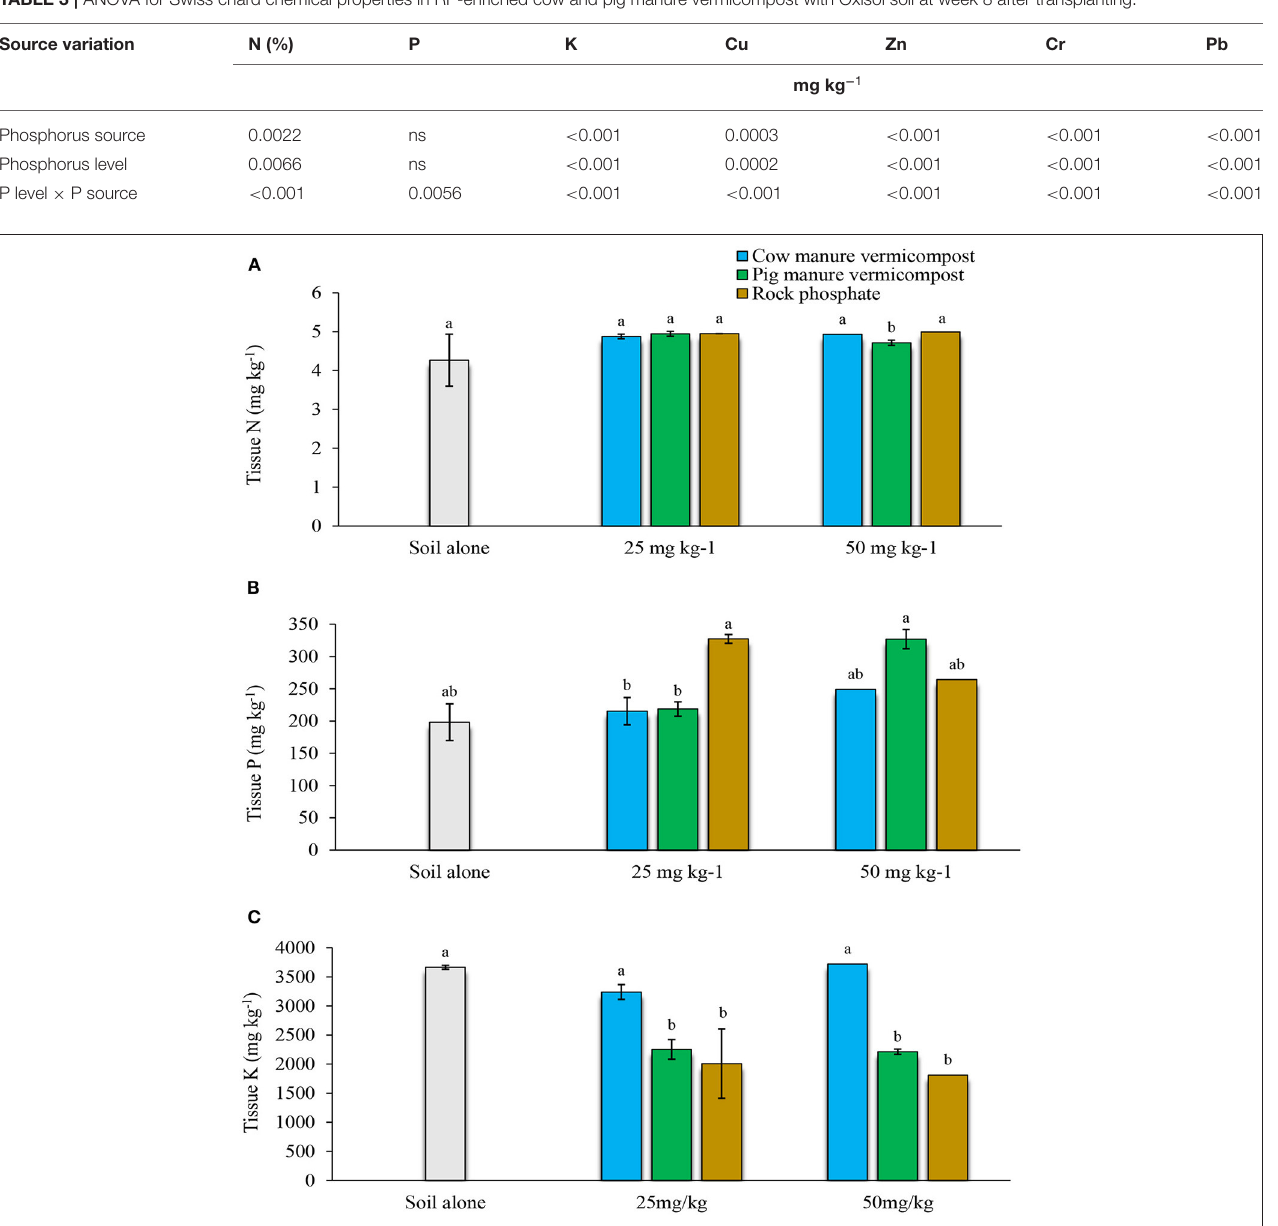
FIGURE 2 | Total N (A) , P (B) , and K (C) content of Swiss chard tissue at week 8 after transplanting using Oxisol soil that has been incorporated with P as RP-enriched cow manure and pig manure vermicompost and RP at a different level. Error bars represent standard deviations, and significantly different numbers for the same parameter are followed by different letters based on LSD ( p ≤